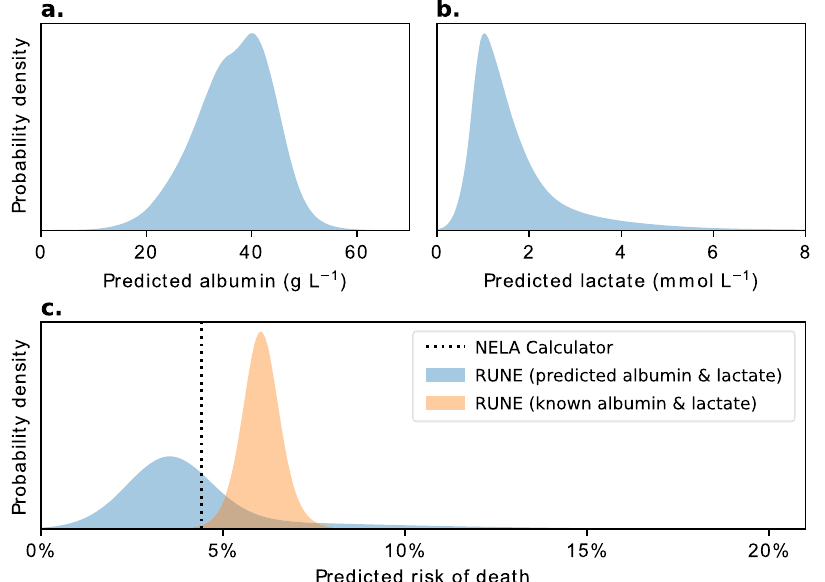
Fig. 4 RUNE ’ s predictions for the case study patient. Lactate and albumin are not measured when the patient is fi rst assessed, and our sub- models, therefore, predict distributions of plausible values for them ( a , b) . Based upon this, RUNE predicts a wide mortality risk distribution ( c , blue), indicating signi fi cant uncertainty which is masked by the point estimate from the NELA calculator. Once albumin and lactate are measured and found to be surprisingly deranged, the predicted albumin and lactate are disregarded, and RUNE makes a con fi dent prediction of higher mortality risk ( c ,